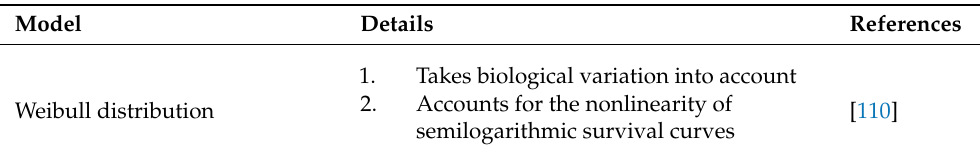
Table 7. Statistical models for D-value estimation and prediction.